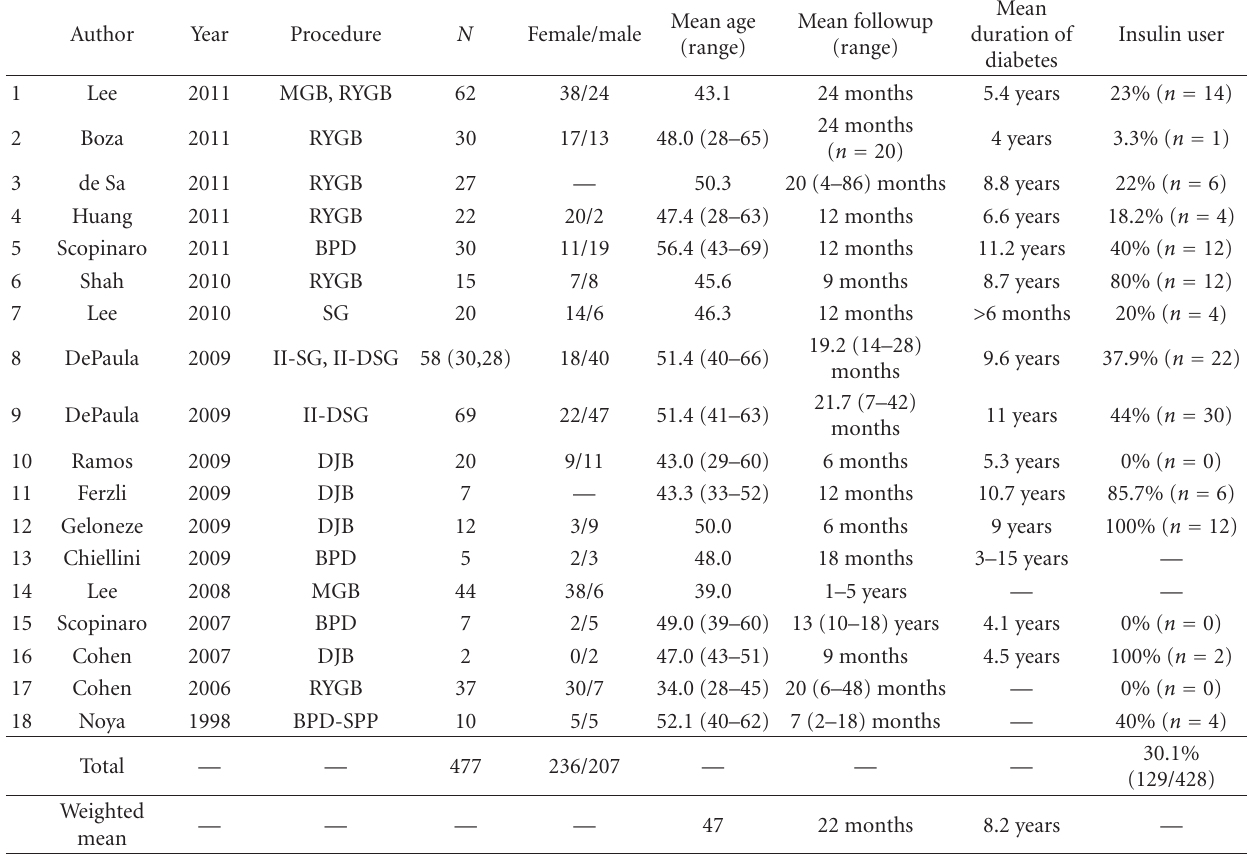
Table 1: Baseline characteristics of T2DM patients with BMI < 35 kg/m 2